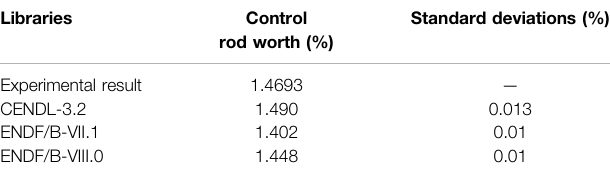
TABLE 4 | Comparison of control rod worth results.